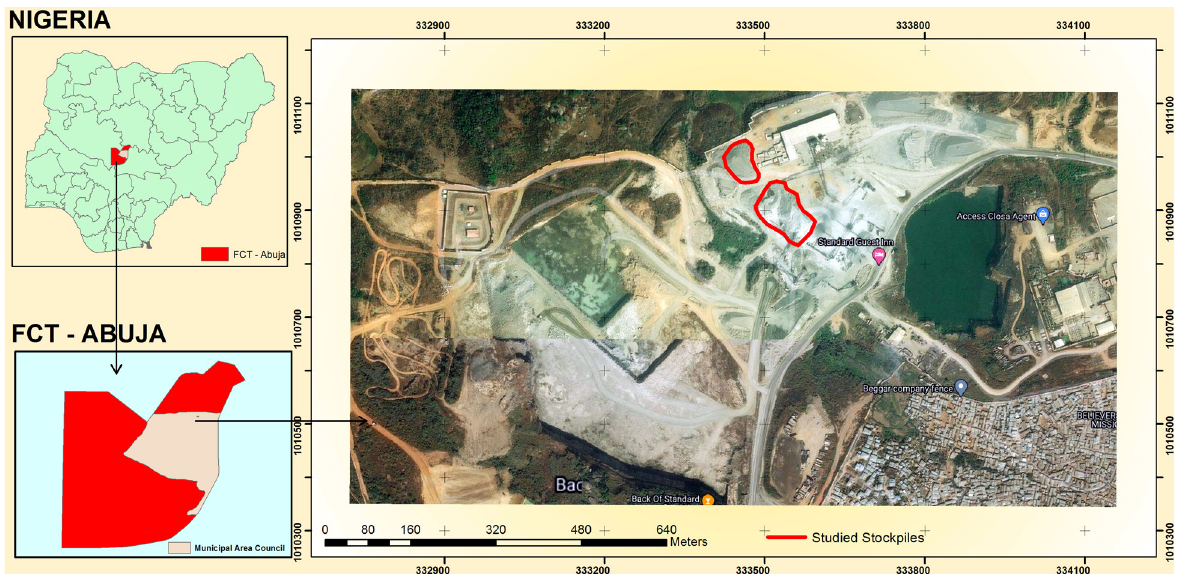
Fig. 1. Diagrammatic representation of the study